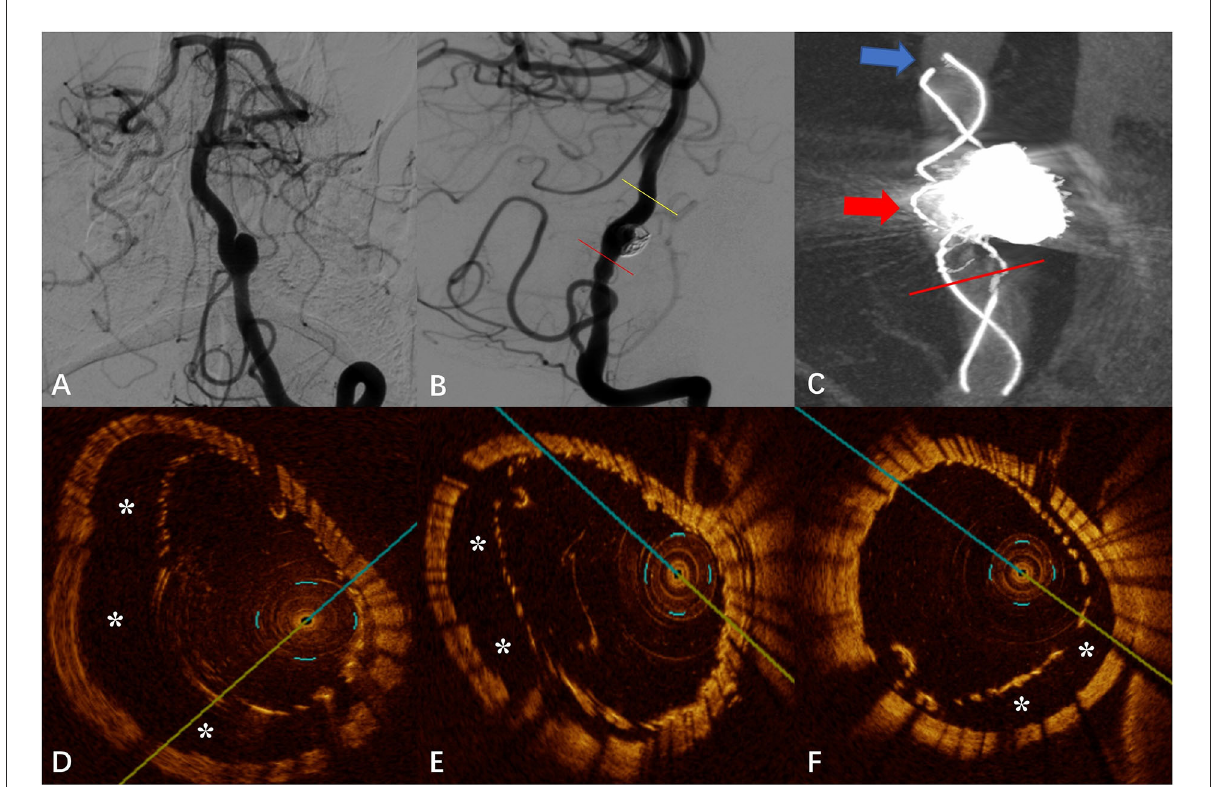
FIGURE3 (A) Digital subtraction angiography (DSA) before the flow-diverter placement. (B) Digital subtraction angiography (DSA) just after the flow-diverter placement. (C) Vaso CT image. Malapposition at the head of the FD (shown by blue arrow) and proximal parent artery with good apposition to the wall. Artifacts near the aneurysm neck that disturb the evaluation of apposition by Vaso CT (shown by red arrow). (D) OCT image. The corresponding blue arrow in (C) . Malapposition at the head of the FD confirmed by Vaso CT before the “massage” of the J-shaped guidewire (*). (E) OCT image. The corresponding yellow line in (B) . Malapposition at the head of the FD confirmed by Vaso CT after the “massage” of the J-shaped guidewire (*). (F) OCT image. The corresponding red line in (B,C) . Localized non-communication malapposition at the proximal of the aneurysm